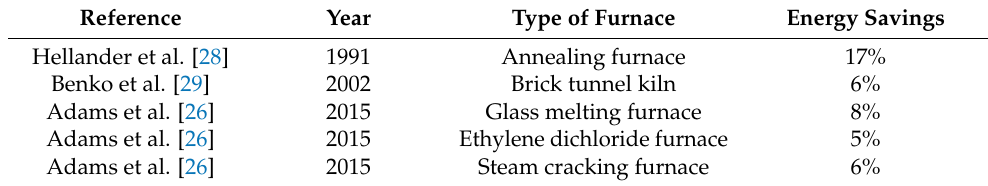
Table 1. Energy savings after applying a high emissivity coating on the furnace refractory reported in